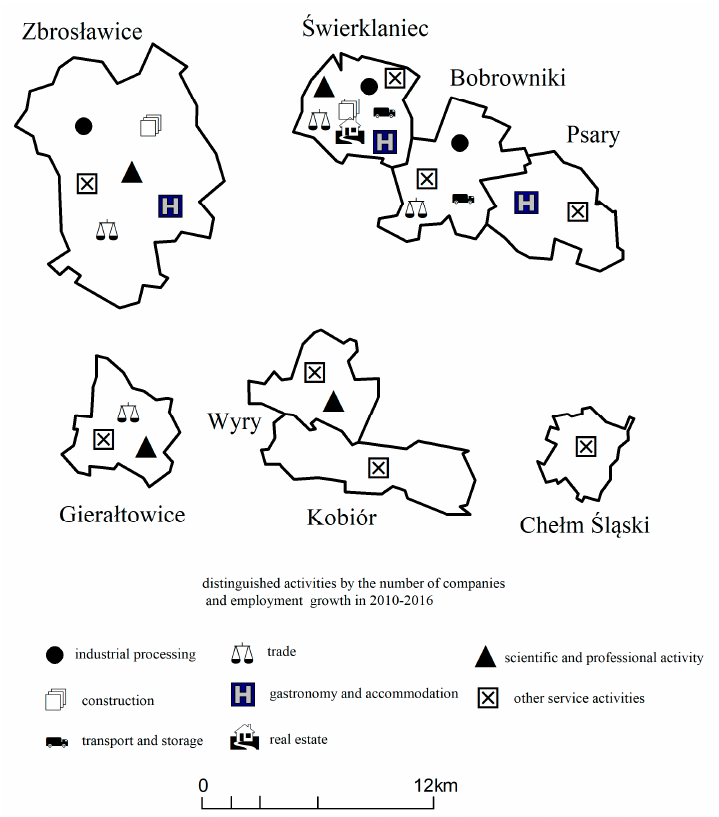
Figure 3. Economic specializations in rural areas in the hinterland of the GZM. Source: Own elabo- ration.